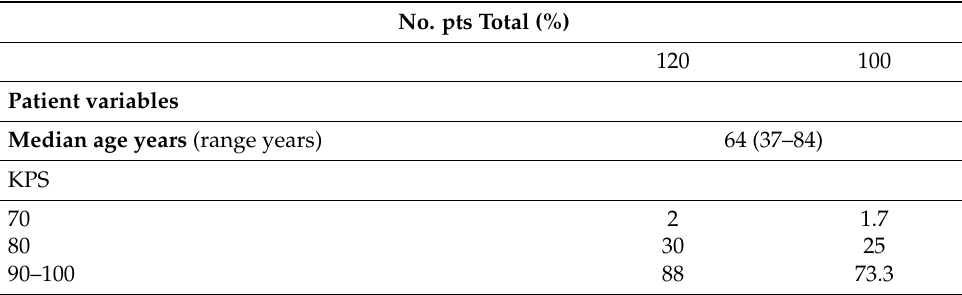
Table 2. Patient, tumor, and treatment characteristics at BM